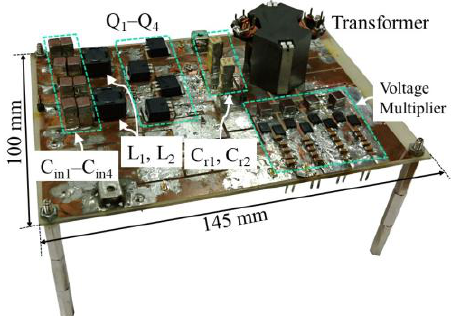
Figure 11. Prototype capable of supplying 60 W for each shaded panel in PV string consisting of four panels connected in series. Table 1. Circuit components used for prototype.